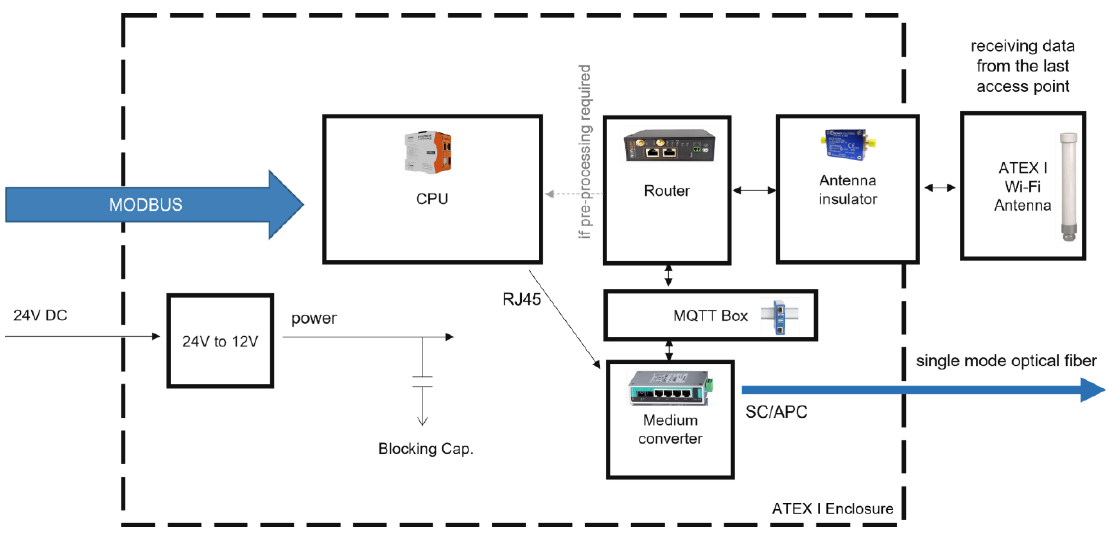
Figure 11. Conceptual block diagram of the gateway developed within the HEET II project. The gateway aggregates data from the access points via the Wi-Fi network, and transmits them to the surface headquarters’ central database through an optical fiber link.